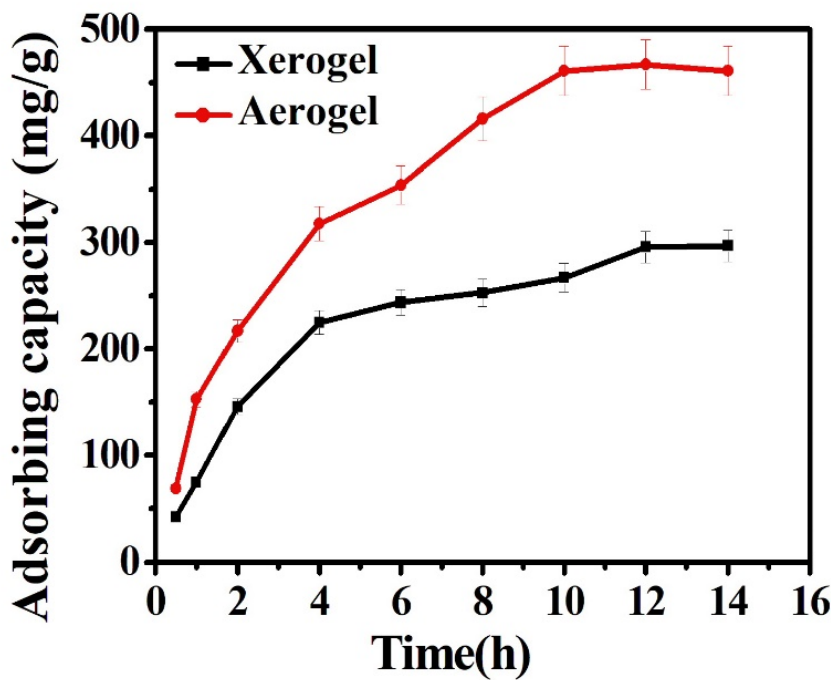
Figure 8. Effects of contact time on the amount of lysozyme adsorbed on the composite aerogel.